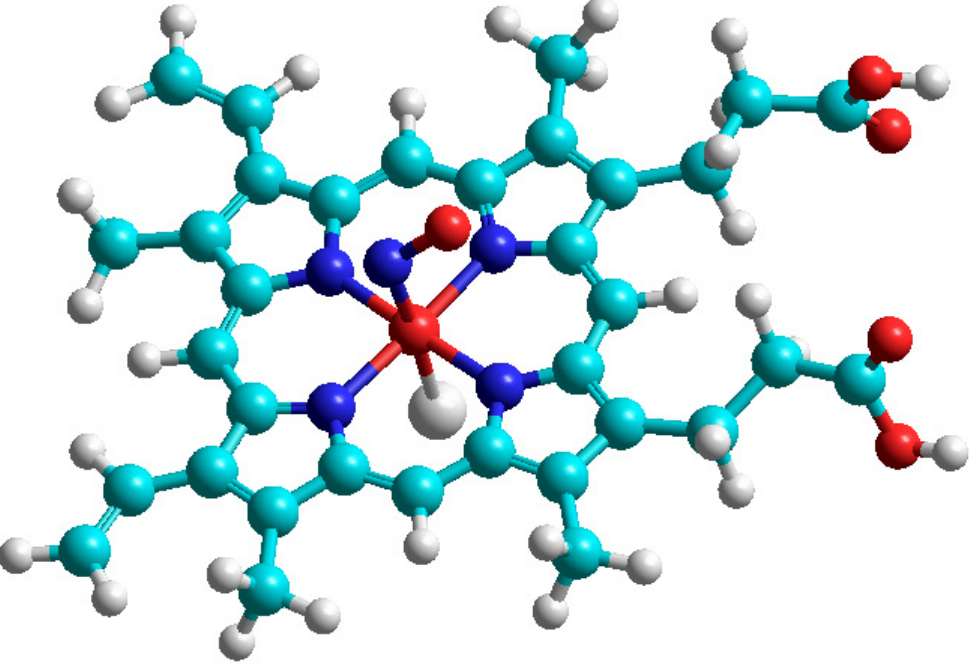
Figure 5. The model of the 2 NO adduct with hemoglobin (coordinated with Cl - anion as a model of - protein residue). Red color for O and Fe atoms, dark blue N, blue C, and grey for H atoms. Adapted from ref. [29]. This is also a calculation made for this paper. The calculated isotropic HFC constant on the 14 N nucleus is equal to a = 15.78 MHz; anisotropic HFC tensor components are calculated at − 30.2, − 7.3, and 37.5 MHz. Thus, the Fermi-coupling a constant is slightly increased by 4.4 MHz in comparison with free NO radical, but the components of the HFC tensor are approximately half-diminished upon 2 NO coordination to the iron center of hemoglobin. The Fe(II) ion provides a rather strong influence on the hyperfine structure of the EPR spectrum of nitric oxide. These results are comparable with our previous theoretical DFT studies of 2 NO and O 2 interactions with hemoglobin [28,29]. Hyperfine coupling on 14 N nucleus is in agreement with the theory of the nitric oxide ESR spectrum made as early as 1950 [30]. 7. Conclusions and Perspectives A newcomer may be very surprised that a singlet molecule 1 O 2 demonstrates an ESR spectrum in the gas phase. Due to the lack of spin in the molecule, it is better to use the term Electron Paramagnetic Resonance, which is achieved in this case where paramagnetism is due to the orbital momentum. The radical 2 NO does not demonstrate the ESR spectrum in liquid solutions. ESR of these and other states can be understood considering the terms of these diatomic molecules. 2 NO is an atmospheric pollutant. 2 NO reacts with dioxygen and produces 2 NO 2 , which is a pollutant as well. In the literature on environmental problems, both pollutants are often called NOx. Air pollutant singlet dioxygen has a relatively short lifetime from milliseconds to less than 10 s [14]. Specific lifetime depends upon pressure and the presence of quenchers of